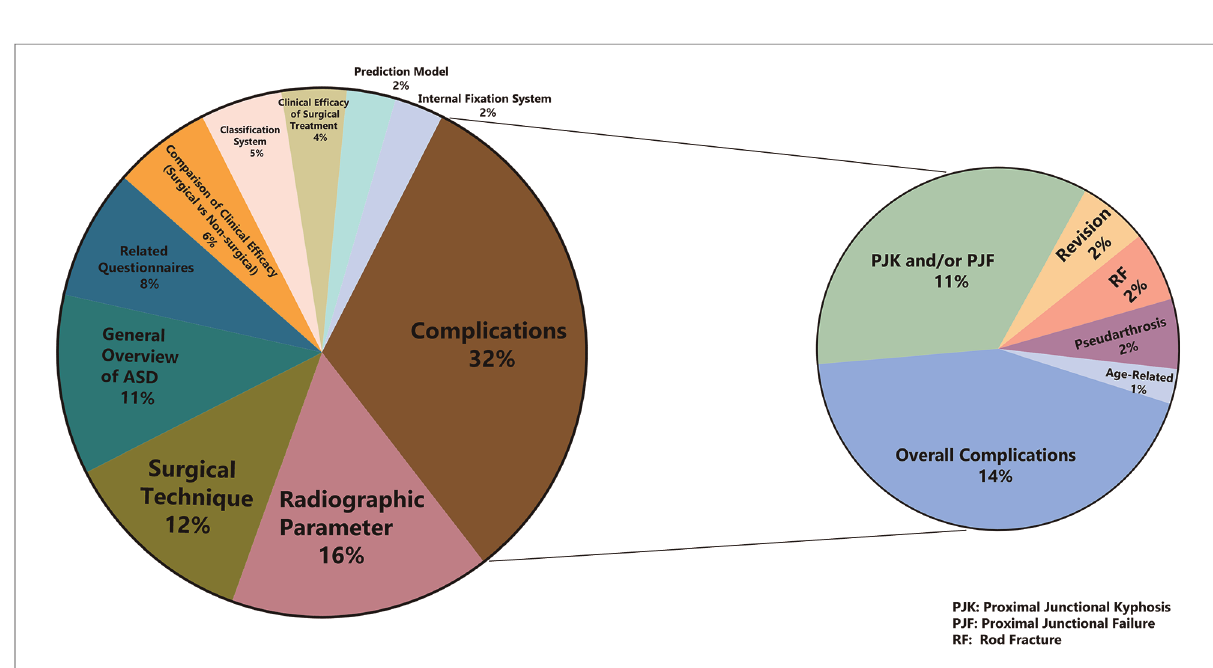
FIGURE 3 The themes for the 100 most-cited articles on